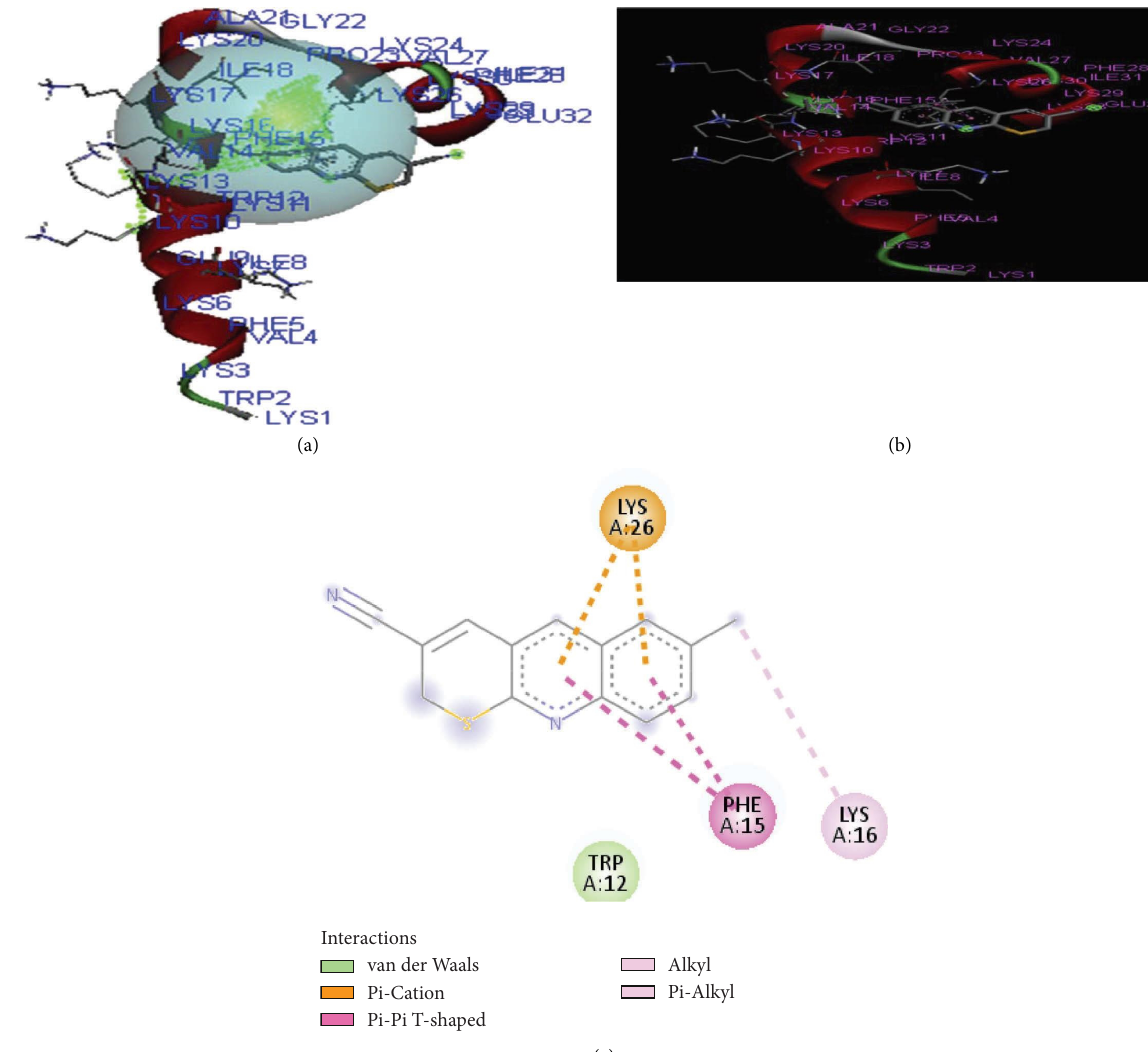
Figure 4: Te binding interaction of 6-methyl-thiopyrano[2,3- b ]quinoline ( 2 ) against CB1a ( PDB ID: 2IGR ) (a) receptor cavities present during interaction, (b) interaction of protein and ligand, and (c)